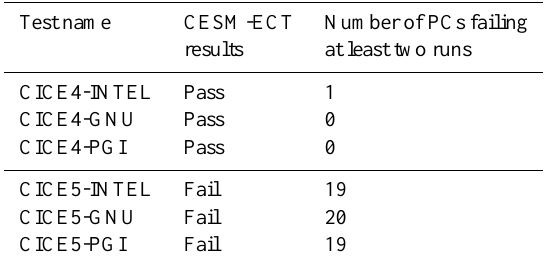
Table 4. CESM development tag with two versions of the CICE component run with different compilers on